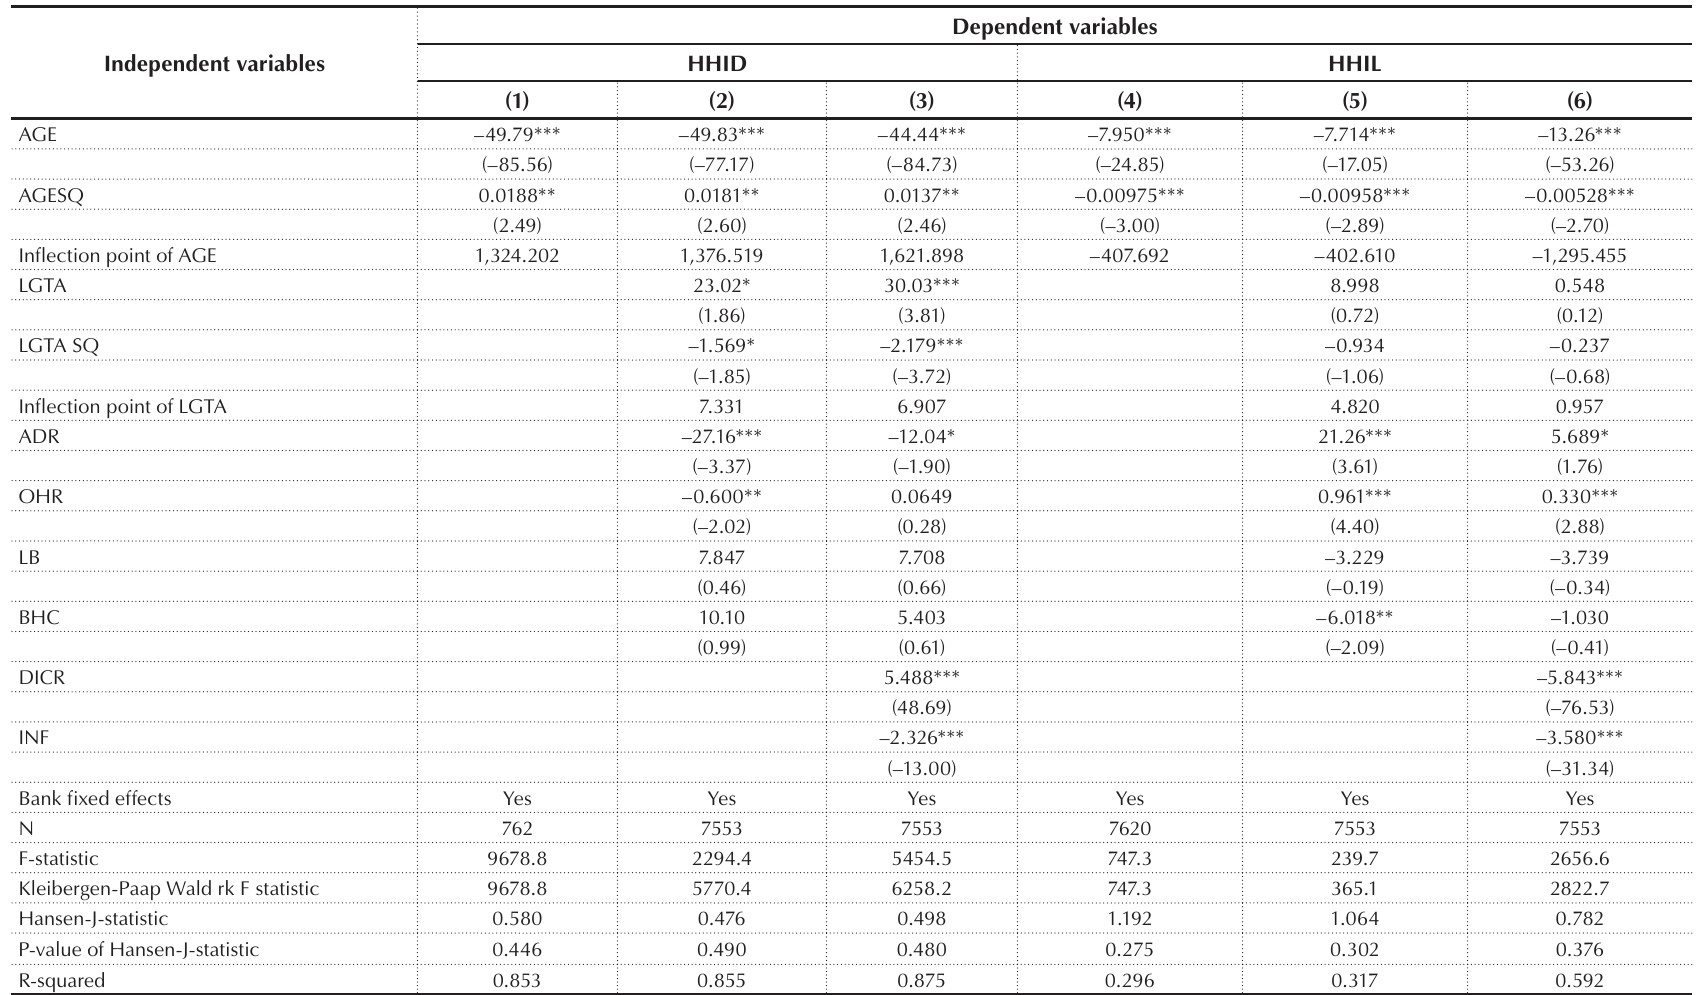
Panel A. First-stage IV regression